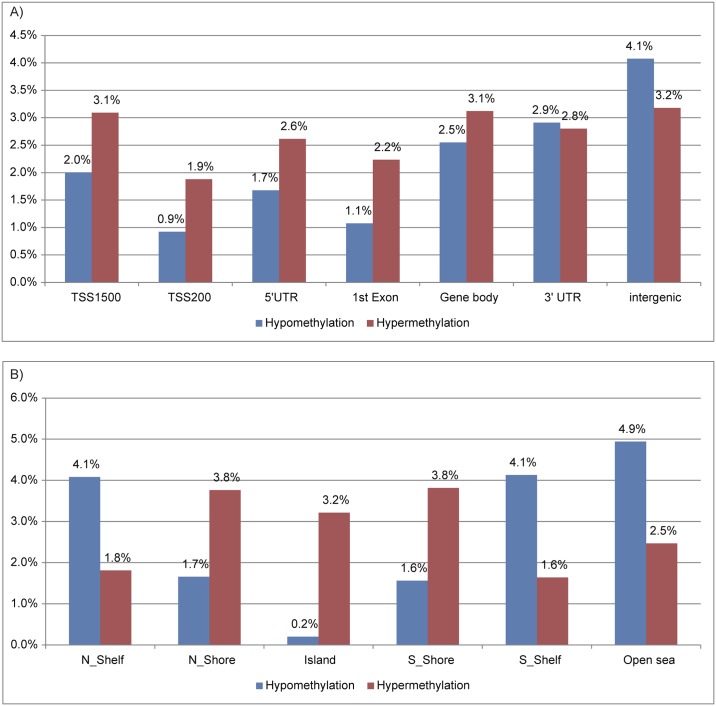
Rates of differentially methylated CpG sites in replicatively senescent TIG-3 cells in seven gene- feature (A) and six CpG- site (B) subcategories.CpG sites showing Δβ > = 0.2 and Δβ = < −0.2 in senescent TIG-3 cells (at PDL 85) compared to those at PDL 36 were regarded as hyper- and hypo-methylated, respectively. Seven gene-feature subcategories: TSS1500, TSS200, 5’UTR, 1st exon, gene body, 3’UTR, and intergenic region. Six CpG subcategories: CpG island, N_Shore, S_Shore, N_Shelf, S_Shelf, and the open sea.